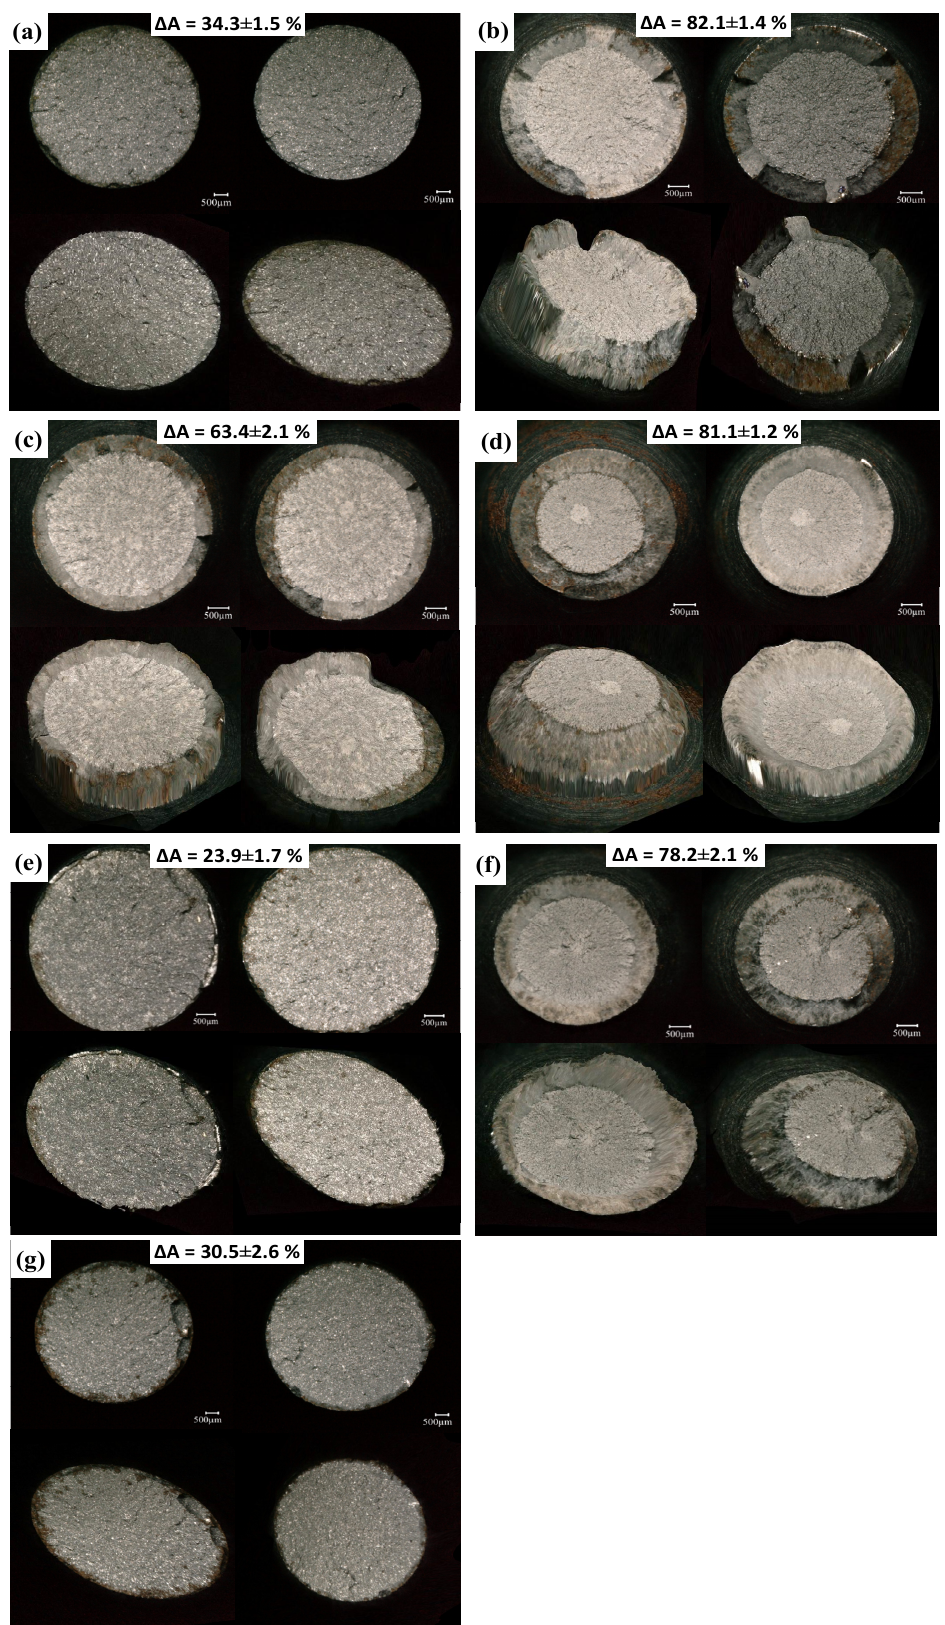
Figure 5. The fracture surfaces and reduction of area ( ∆ A ) of all tensile samples, up (2D image) and down (3D image); ( a ) B360-AR, ( b ) B360-HT, ( c ) B1400-AR, ( d ) B1400-HT, ( e ) CrB-AR, ( f ) CrB-HT and ( g ) R350HT.